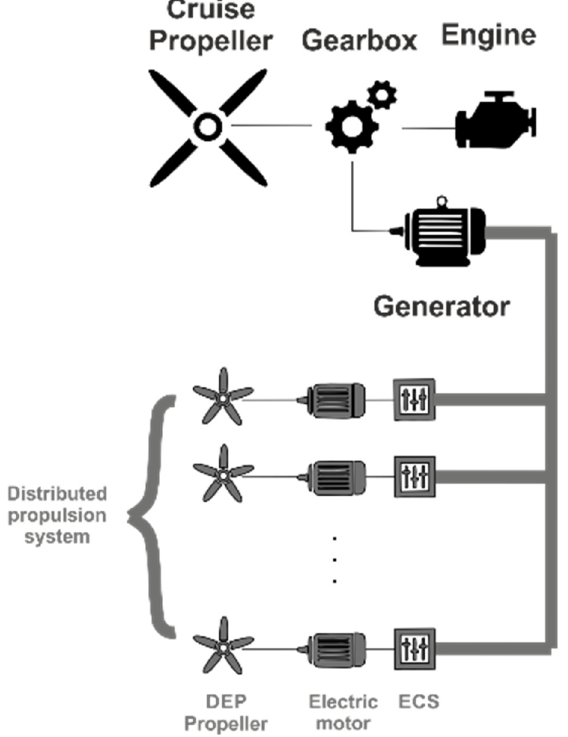
Figure 5. Schematic of the series-parallel DEP system arrangement.